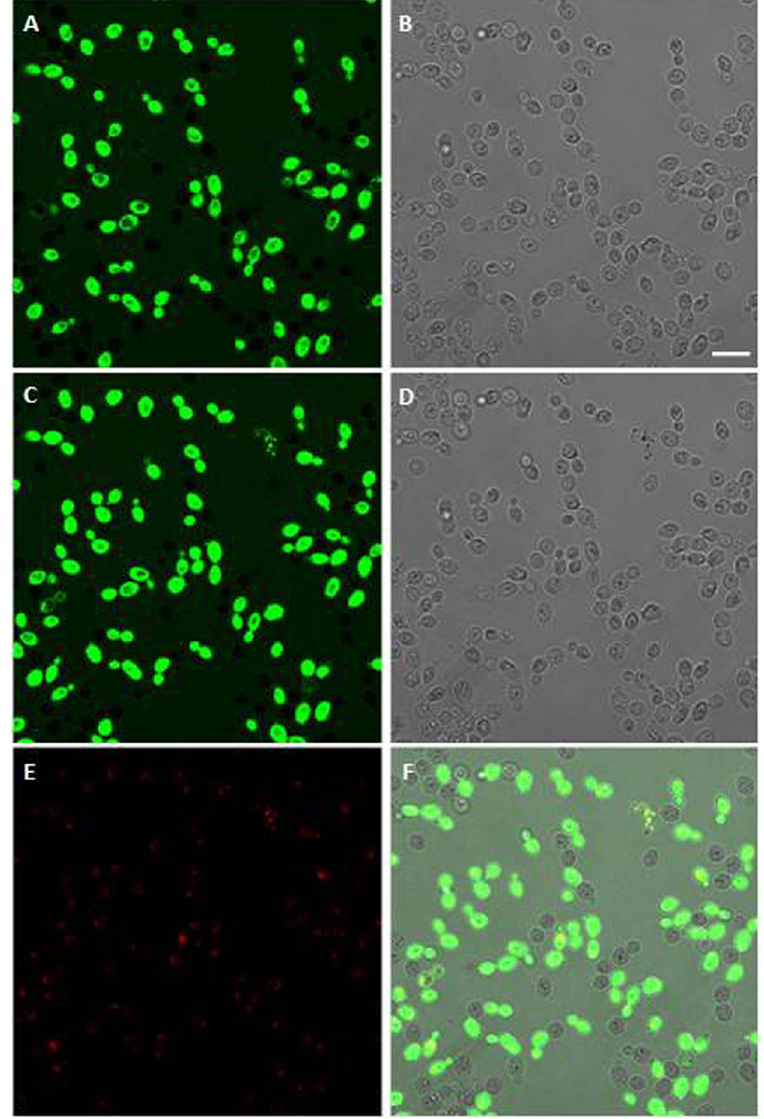
Figure 3. Internalisation of the L12P peptide into Candida albicans SC5314 cells. Confocal images of living yeast cells incubated in the presence of the fluorescein-labeled peptide for 5 min and 15 min are presented in panels A and C, respectively. The same field is shown by light transmission images in panels B (5 min) and D (15 min). L12P entered into most yeast cells within few minutes; empty vacuoles were seen. After 15 min, some yeast cells were entirely fluorescent and no longer viable as assessed by propidium iodide internalisation (panel E). Panel F: merge of panels C and E. Bar = 10 μ